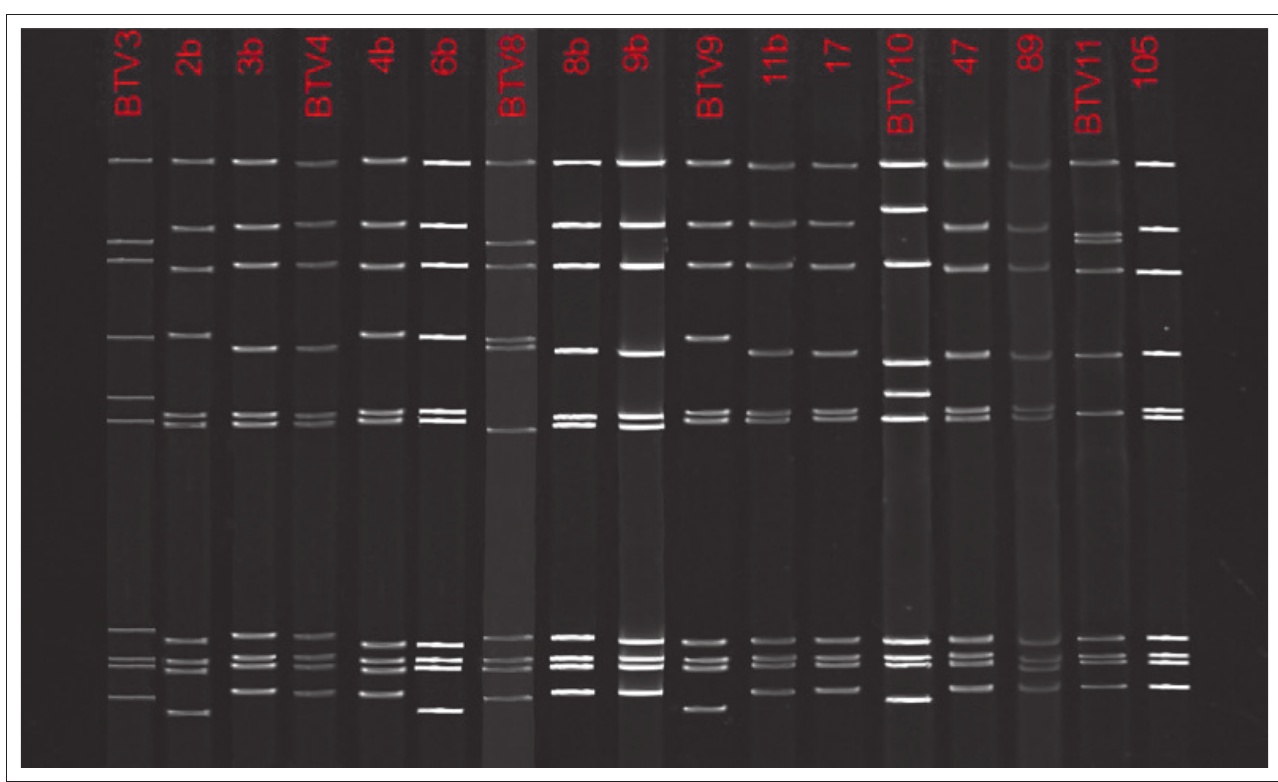
FIGURE 3: Double-stranded ribonucleic acid of plaque-purified viral samples directly from the buffy coat of animal numbers 1, 4 and 5 compared to the parental viruses. The majority of the sample resembles bluetongue virus serotype 4, while viruses 2b and 6b resemble bluetongue virus serotype 9.